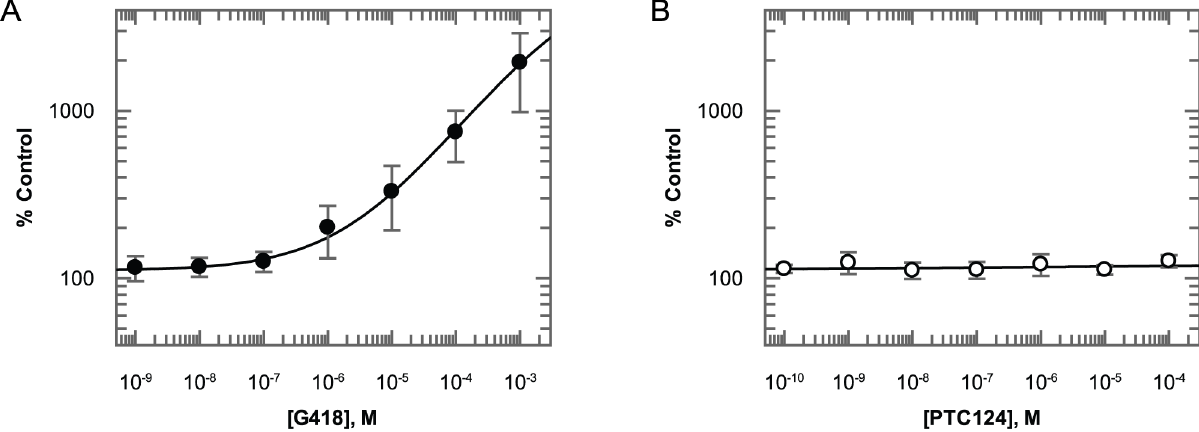
Figure 3. Lack of PTC124 efficacy with a transiently transfected RLuc PTC-reporter. (A) Incubation with G418 for 24 hours leads to a dose- dependent increase in enzyme activity of transiently transfected PTC-RLuc. (B) 24-hour incubation with PTC124 at concentrations in excess of its reported effective concentration range of 0.1–0 m M has no effect. All data points represent mean 6 standard deviation (n=5).